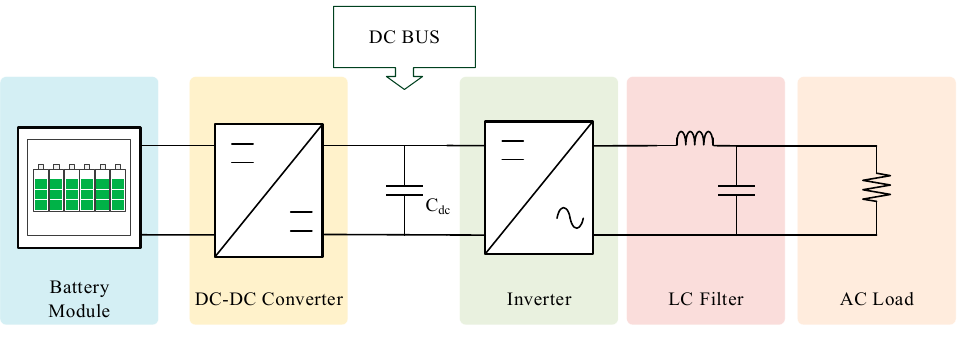
Figure 2. The traditional topology of a BESS.